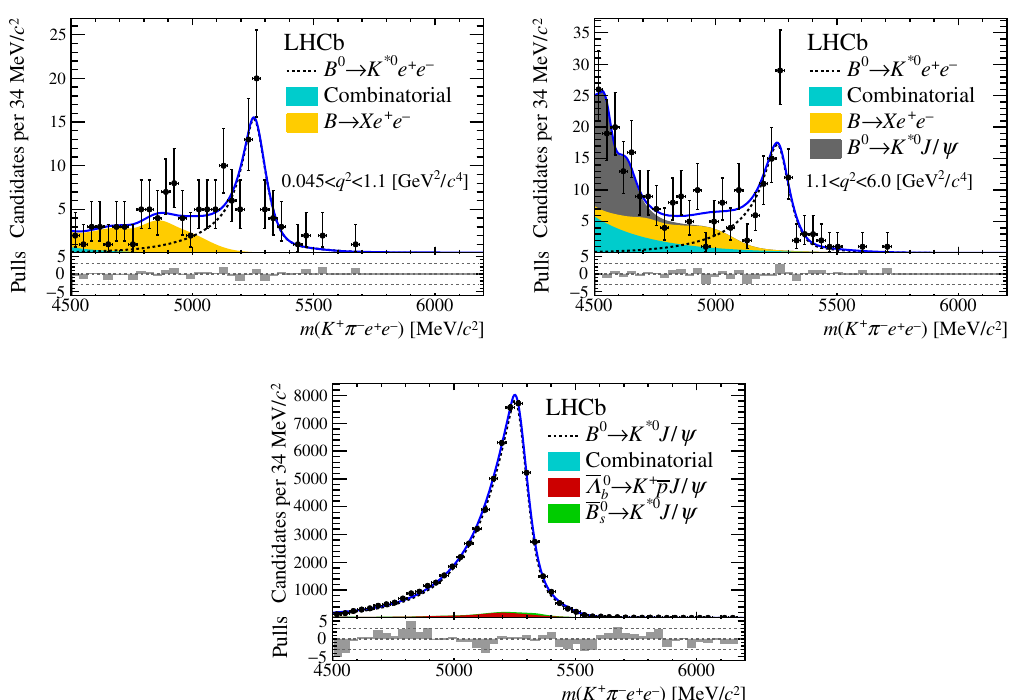
Figure 7 . Fit to the m ( K + (cid:25) (cid:0) e + e (cid:0) ) invariant mass of (top) B 0 ! K (cid:3) 0 e + e (cid:0) in the low- and central- q 2 bins and (bottom) B 0 ! K (cid:3) 0 J= ( ! e + e (cid:0) ) candidates. The dashed line is the signal PDF, the shaded shapes are the background PDFs and the solid line is the total PDF. The (cid:12)t residuals normalised to the data uncertainty are shown at the bottom of each